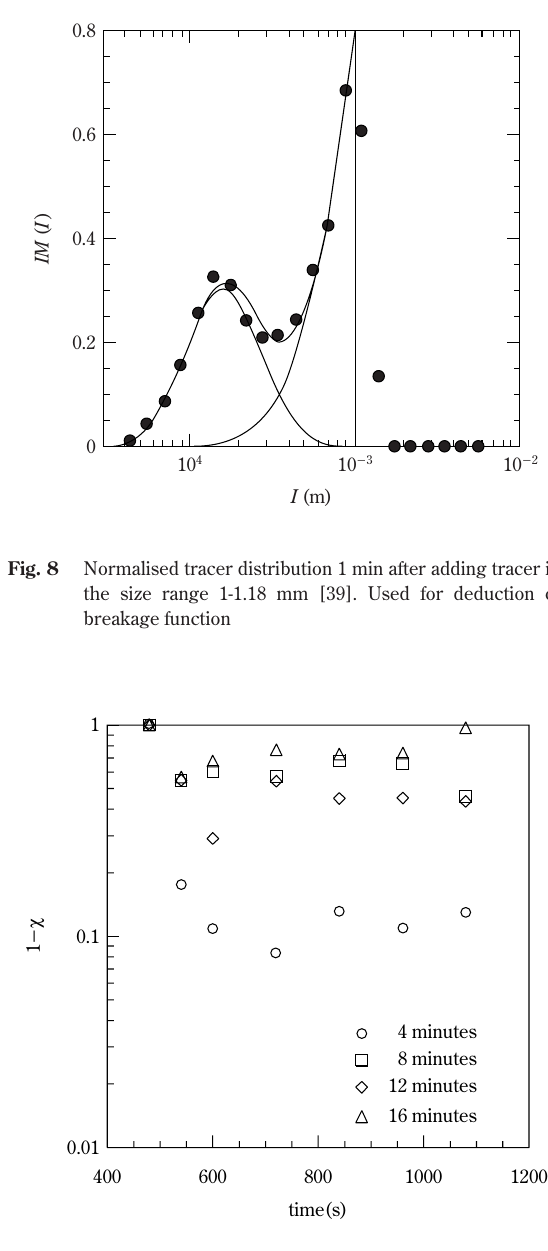
Fig. 9 Fraction of tracer relegated for tracers of four different ages, but a constant size of 1.09 mm. All tracers were added after 8 minutes of granulation